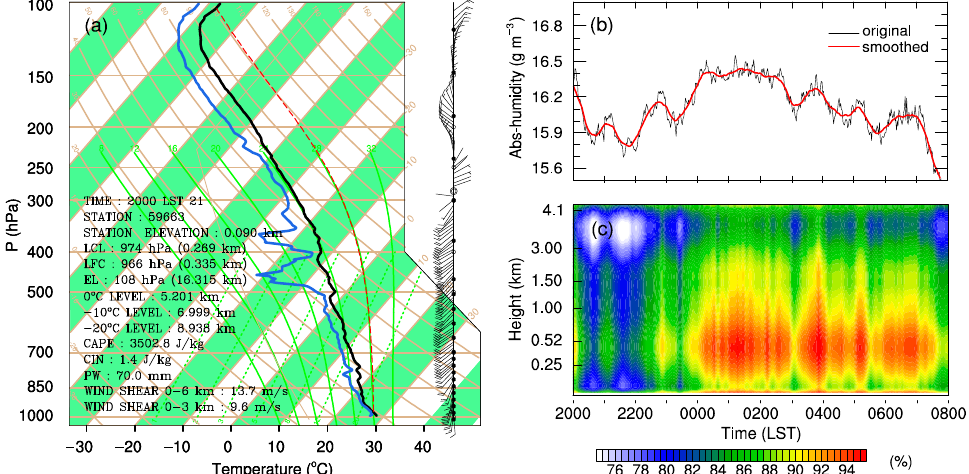
Figure 6 . ( a ) The skew T-logP diagram and vertical wind profile (wind barbs, a full barb is 5 m s − 1 ) of the YJ sounding station at 2000 LST on 21 June. The black and blue lines are the temperature and dewpoint temperature profiles, respectively. The red dotted curve is the ascending path of a surface-based parcel. ( b ) Time series of water vapor content averaged below 4 km and ( c ) time–height distribution of relative humidity based on the microwave radiometer measurements at Bohe. Table 1. Comparison of relative humidity (%) at 2000 LST on 21 June 2017 and historical (2011–2020) relative humidity at 2000 LST in June based on the YJ soundings.